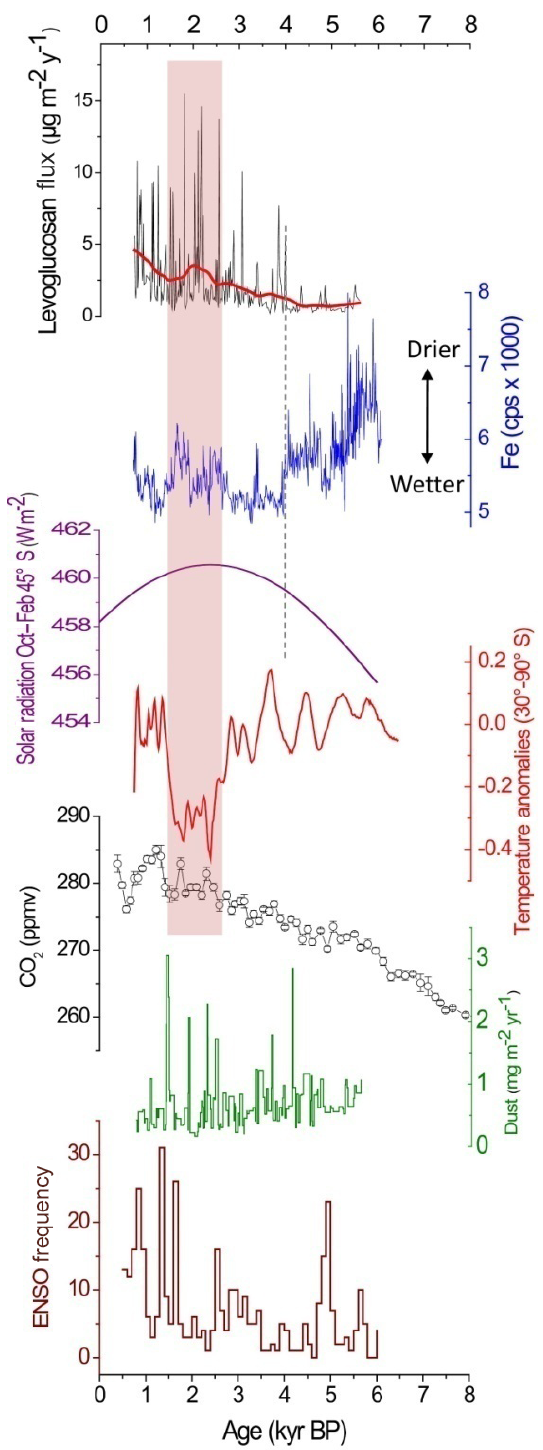
Figure 4. Levoglucosan flux and Fe content in marine sediments from southern Chile (from Lamy et al., 2001); October–February 45 ◦ S solar radiation (from Laskar et al., 2004), temperature anoma- lies between 30 and 90 ◦ S (Marcott et al., 2013), CO 2 from Taylor Dome (Indermühle et al., 1999), dust from Talos Dome (Albani et al., 2012) and ENSO 100-year frequency (Moy et al.,